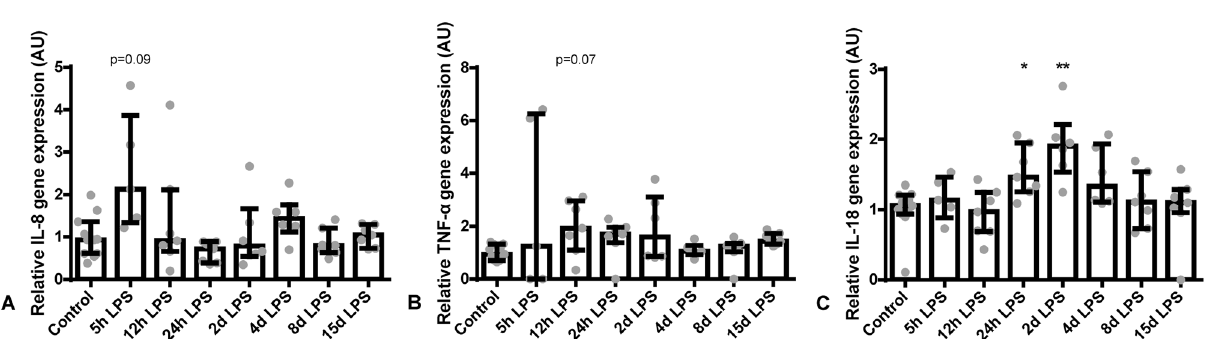
Figure 3. Relative mRNA expression of IL-8 ( A ), TNF-α ( B ) and IL-18 ( C ) in AU in the liver. Data are presented as median with IQR. A: IL-8 tended to increase 5 hours after IA LPS administration. P = 0.09 compared to control. B: TNF-α mRNA levels tended to be increased 12 hours after IA LPS administration. P = 0.07 compared to control. C: IL-18 mRNA levels were increased at 24 hours and 2 days after IA LPS administration. * P = 0.05 and ** P < 0.005 compared to